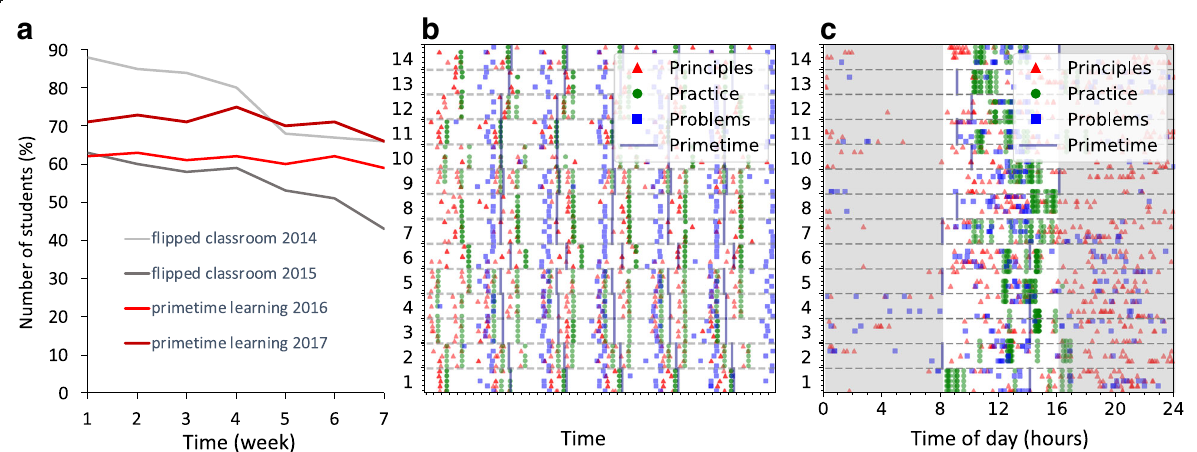
Fig. 4 Analysis of TEL environment log data. a The number of active students in the course plotted using the number of students who actively solved problems. b Timestamps for principles (red triangles), practice (green circles), problem answer submissions (blue squares), and primetimes (vertical lines) for each student as a function of time. Groups are numbered and separated by horizontal dashed lines. Data are shown only for 2016; data for 2017 are similar. c The data of the panel b compressed to 1 day and night. Shaded areas indicate the time of day outside 8 am and 4